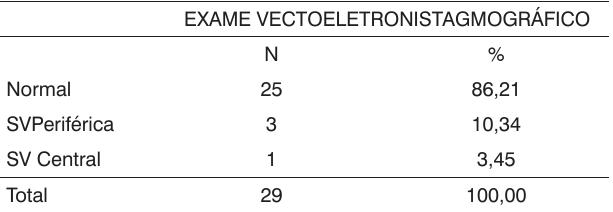
Tabela 4. Resultados obtidos na conclusão do Exame Vectoeletro- nistagmográfico pelos indivíduos do grupo